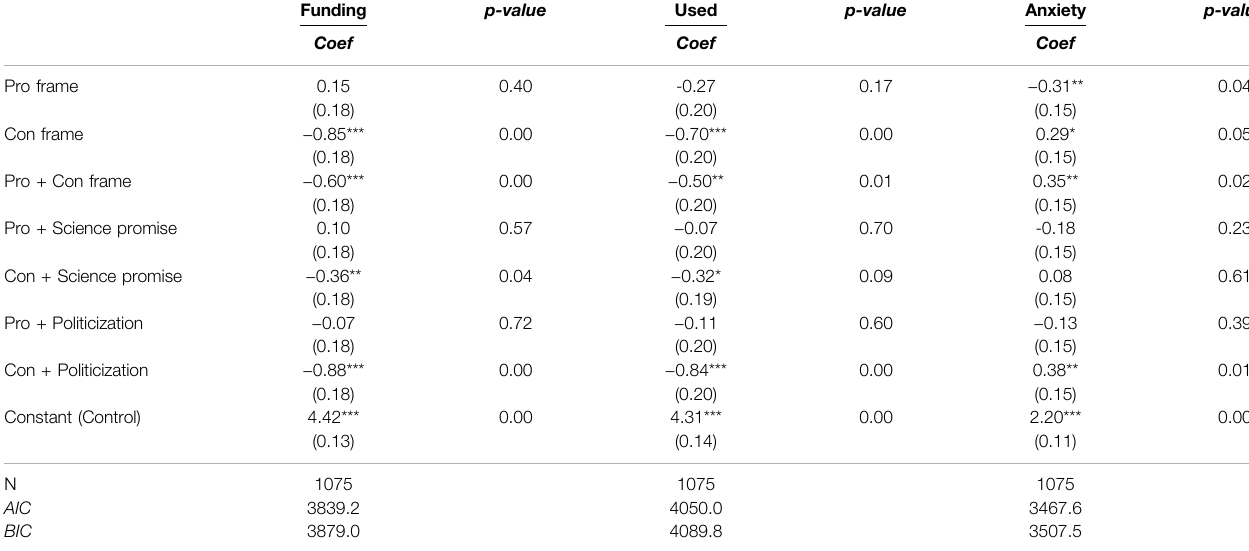
TABLE 2 | Main Treatment Effects